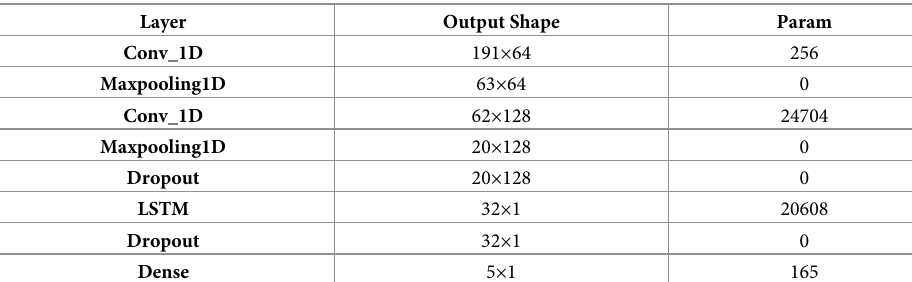
Table 3. Network parameter table.